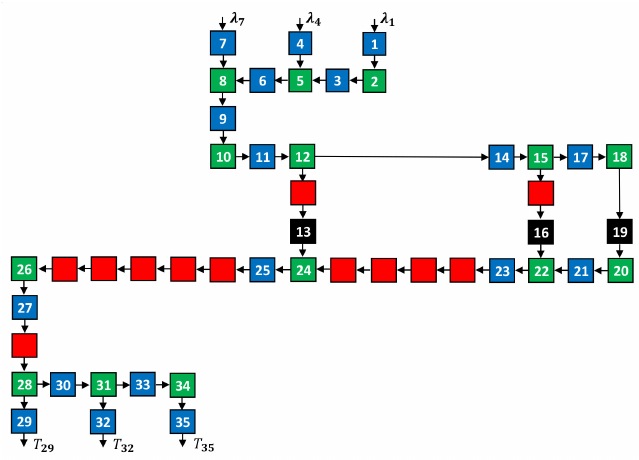
Figure 21. Production line topology after bu ff ers are allocated by API-VNS in the case of λ = 0.2 in experiment